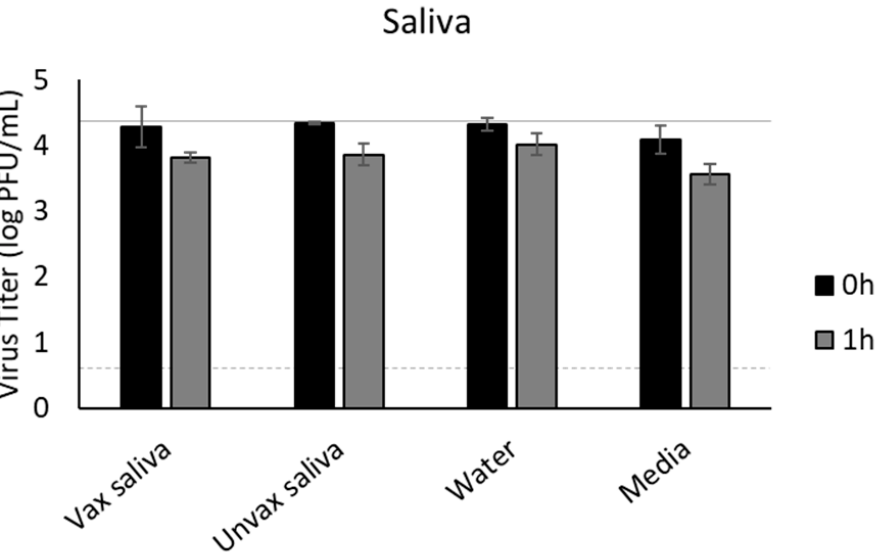
Figure 7. Survival of SARS-CoV-2 in saliva from vaccinated (vax saliva) and unvaccinated (Unvax saliva) individuals compared to water and media controls. SARS-CoV-2 was recovered immediately after inoculation (0 h) and at 1 h and 7 d after inoculation, quantified by plaque assay on Vero E6 cells, and shown as log PFU/mL. The inoculum is shown as a solid gray line (4.3 log PFU/mL) and the detection limit of the plaque assay is shown as a dashed line (0.7 log PFU/mL). No statistically significant differences were identified. Error bars = SEM.